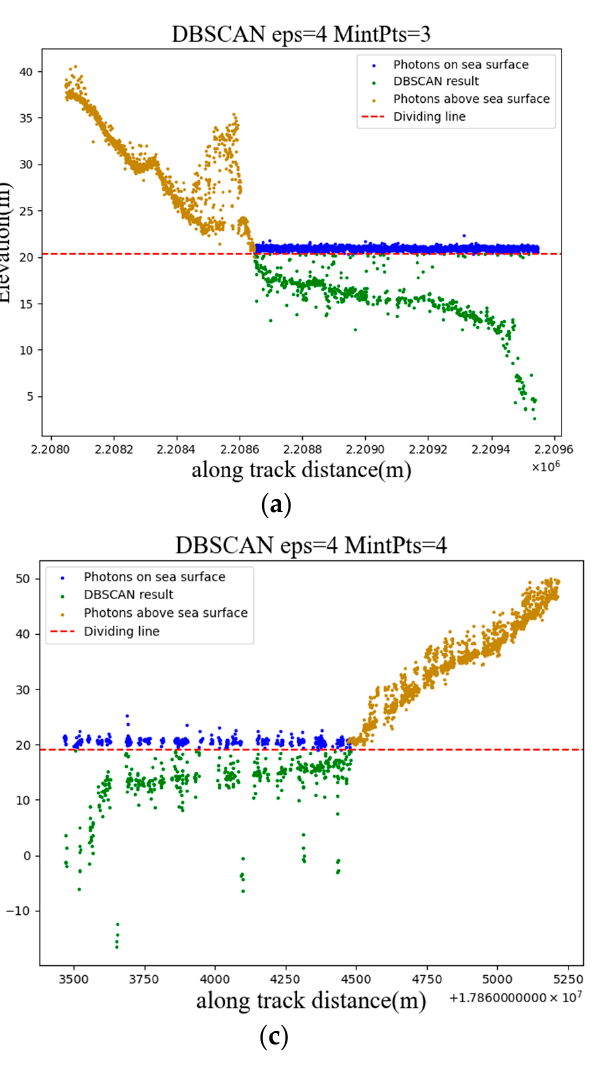
Figure 7. ( a ) DBSCAN denoised 480 orbit gt1r beam after parameter adjustment (eps = 4, Mintpts = 3); ( b ) DBSCAN denoised 480 orbit gt2r beam after parameter adjustment (eps = 3, Mintpts = 2); ( c ) DBSCAN denoised 1036 orbit gt2r beam after parameter adjustment (eps = 4, Mintpts = 4); ( d ) DBSCAN denoised 1036 orbit gt1r beam after parameter adjustment (eps = 3, Mintpts = 4).